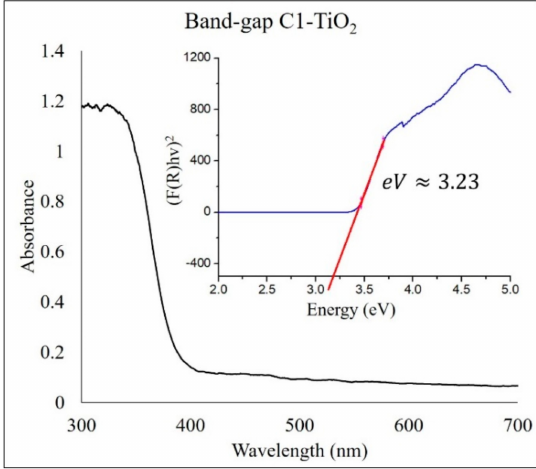
Figure 4. Band-gap calculation, according to the absorbance spectrum of C1-TiO 2 , by means of the graphic representation [F(R)¯ h υ ] 2 against ¯ h υ of the Kubelka–Munk